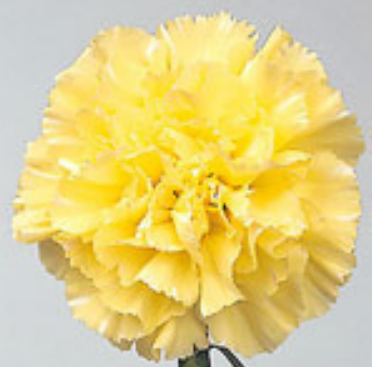
Fig. 1. Carnation ( Dianthus caryophyllus L. cv. ‘Yellow Candy’) cut flower with pale yellow color